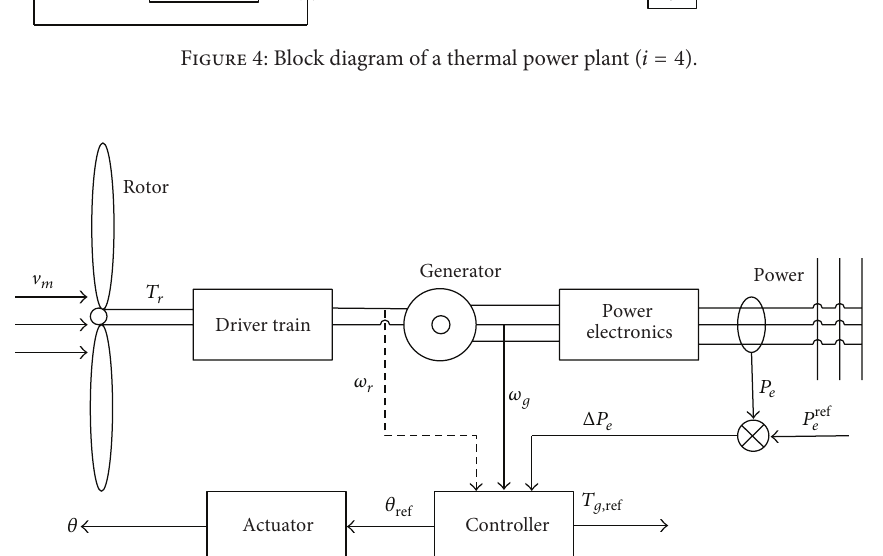
Figure 5: Diagram of a variable speed wind